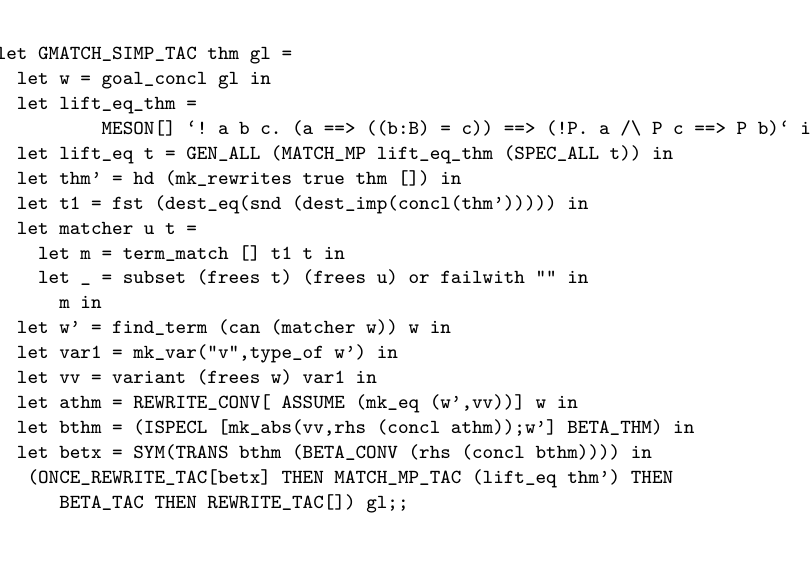
Fig. 3. A bespoke Flyspeck tactic from general/hales tactic.hl